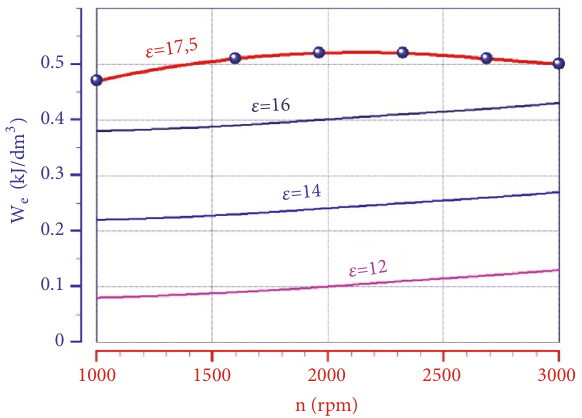
Figure 12: Influence of the (CR) on particles emission.